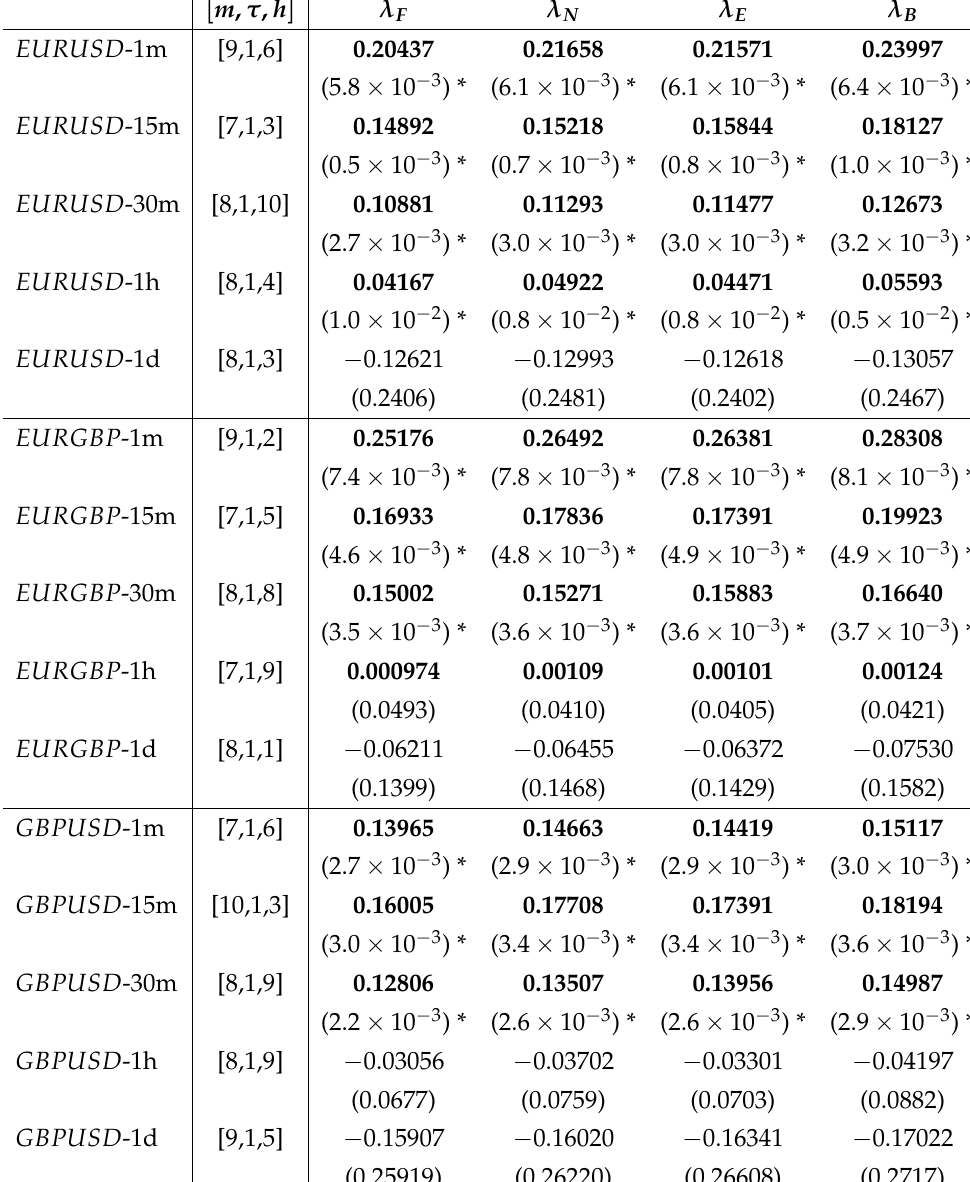
Table 4. Lyapunov exponents from best fit neural net model for each blocking method (ˆ λ F = full, ˆ λ ˆ λ ˆ λ N = nonoverlapping, E = equally spaced, and B = bootstrap) from the EURUSD, EURGBP, and GB- PUSD returns time series for each time frequency considered over the last 15 years. Standard errors are given in parentheses, and the set of optimal parameters [ m , τ , h ] are indicated in brackets. We highlight Lyapunov exponents with positive values in bold and those that are statistically significant at the 99% confidence level with asterisks ∗ . The median values of all blocks used for estimation based on blocking methods are presented. The block length M was chosen following